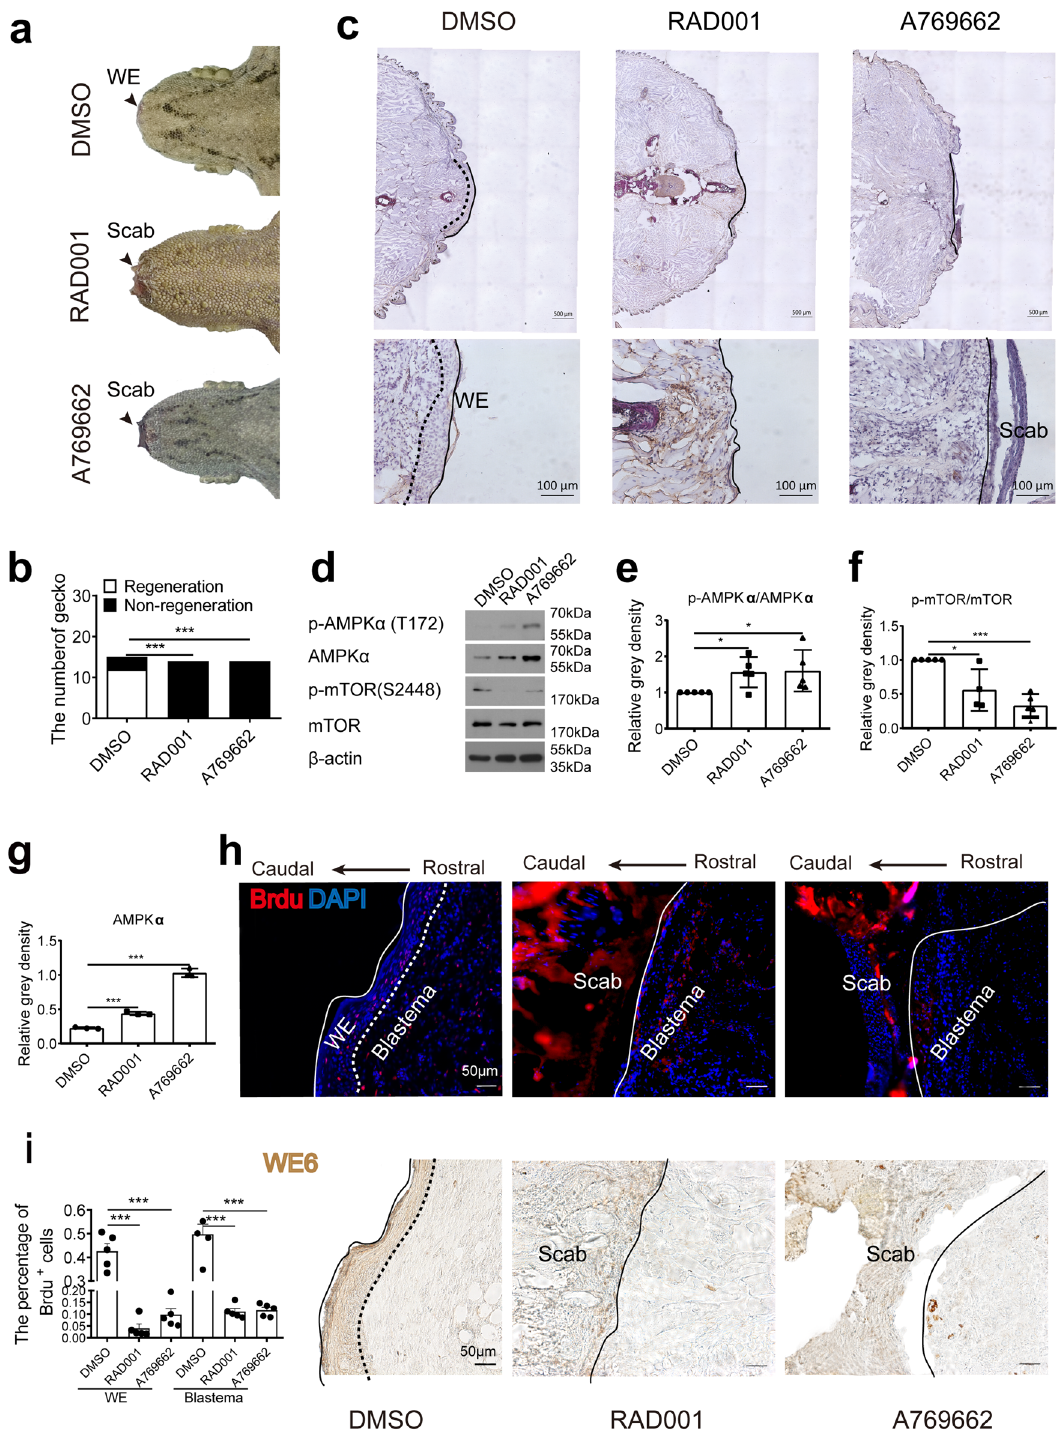
Fig. 7 AMPK activation reduced the proliferation of wound epithelium. a Formation of wound epithelium (WE) in control (DMSO), mTOR inhibition (RAD001), and AMPK activation groups (A769662). b Number of geckos with regeneration in control, RAD001, and A769662 groups. N = 15. c H&E staining of tail tissues in control, RAD001, and A769662 groups. Solid arrow indicates the injury site, dashed box indicates the magni fi ed area, dotted line indicates border between wound epithelium and scab, and solid line indicates junction between rostral end of wound epithelium and blastema. Scale bar = 500 µ m or 100 µ m. N = 3. d Protein level of AMPK α , p-AMPK α (Thr172), mTOR, and p-mTOR (Ser2448) in tail tissues. e – g Relative level of proteins in Fig. 7d. h Immuno fl uorescence analysis of BrdU staining in control, RAD001 and A769662 group (upper panel). Immunohistochemical analysis of WE6 staining in the same location of the samples. Solid line indicates the caudal border of wound epithelium, dotted line indicates border between wound epithelium and blastema. Scale bar = 50 µ m. i Number of BrdU positive cells in control, mTOR inhibition, and AMPK activation groups. Values represent mean ± SD, N = 5, ns p > 0.05, * p < 0.05, ** p < 0.01, *** p <